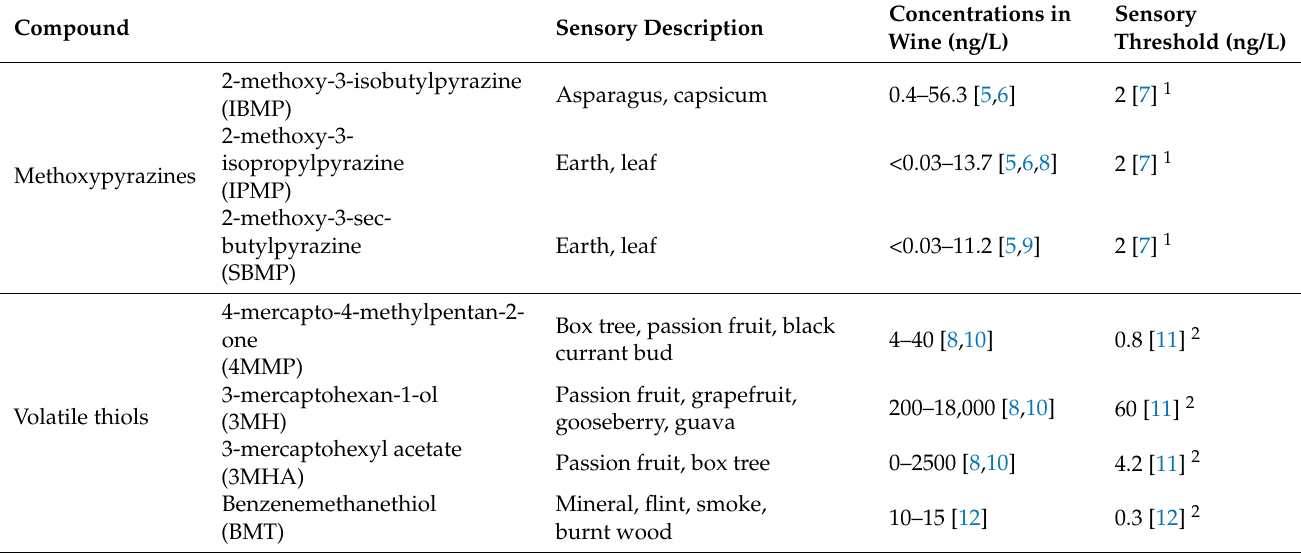
Table 1. Key varietal compounds in Sauvignon Blanc wines.